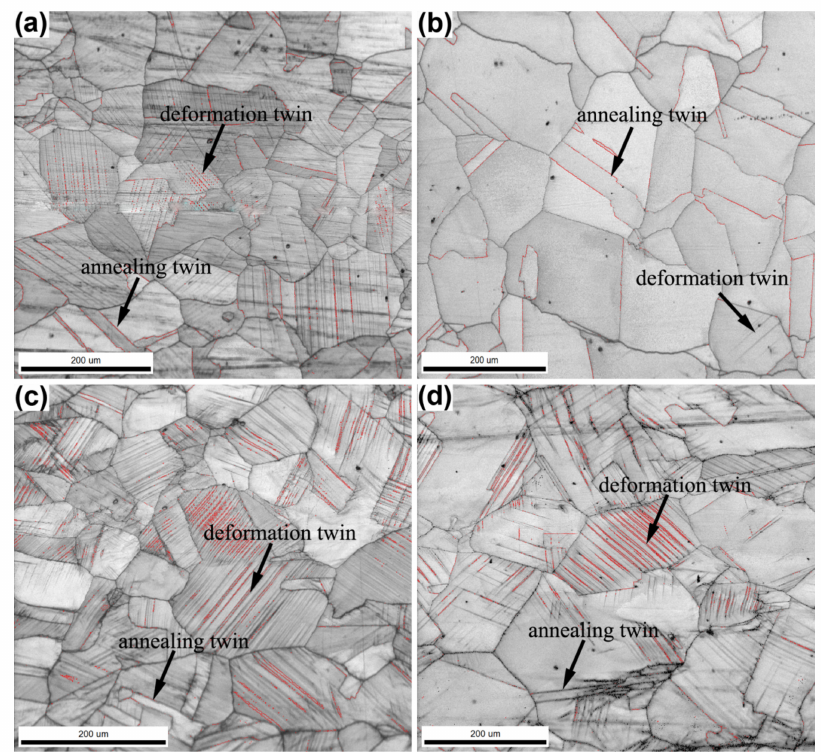
Figure 6. EBSD images of two test steels after tensile deformation with different deformation